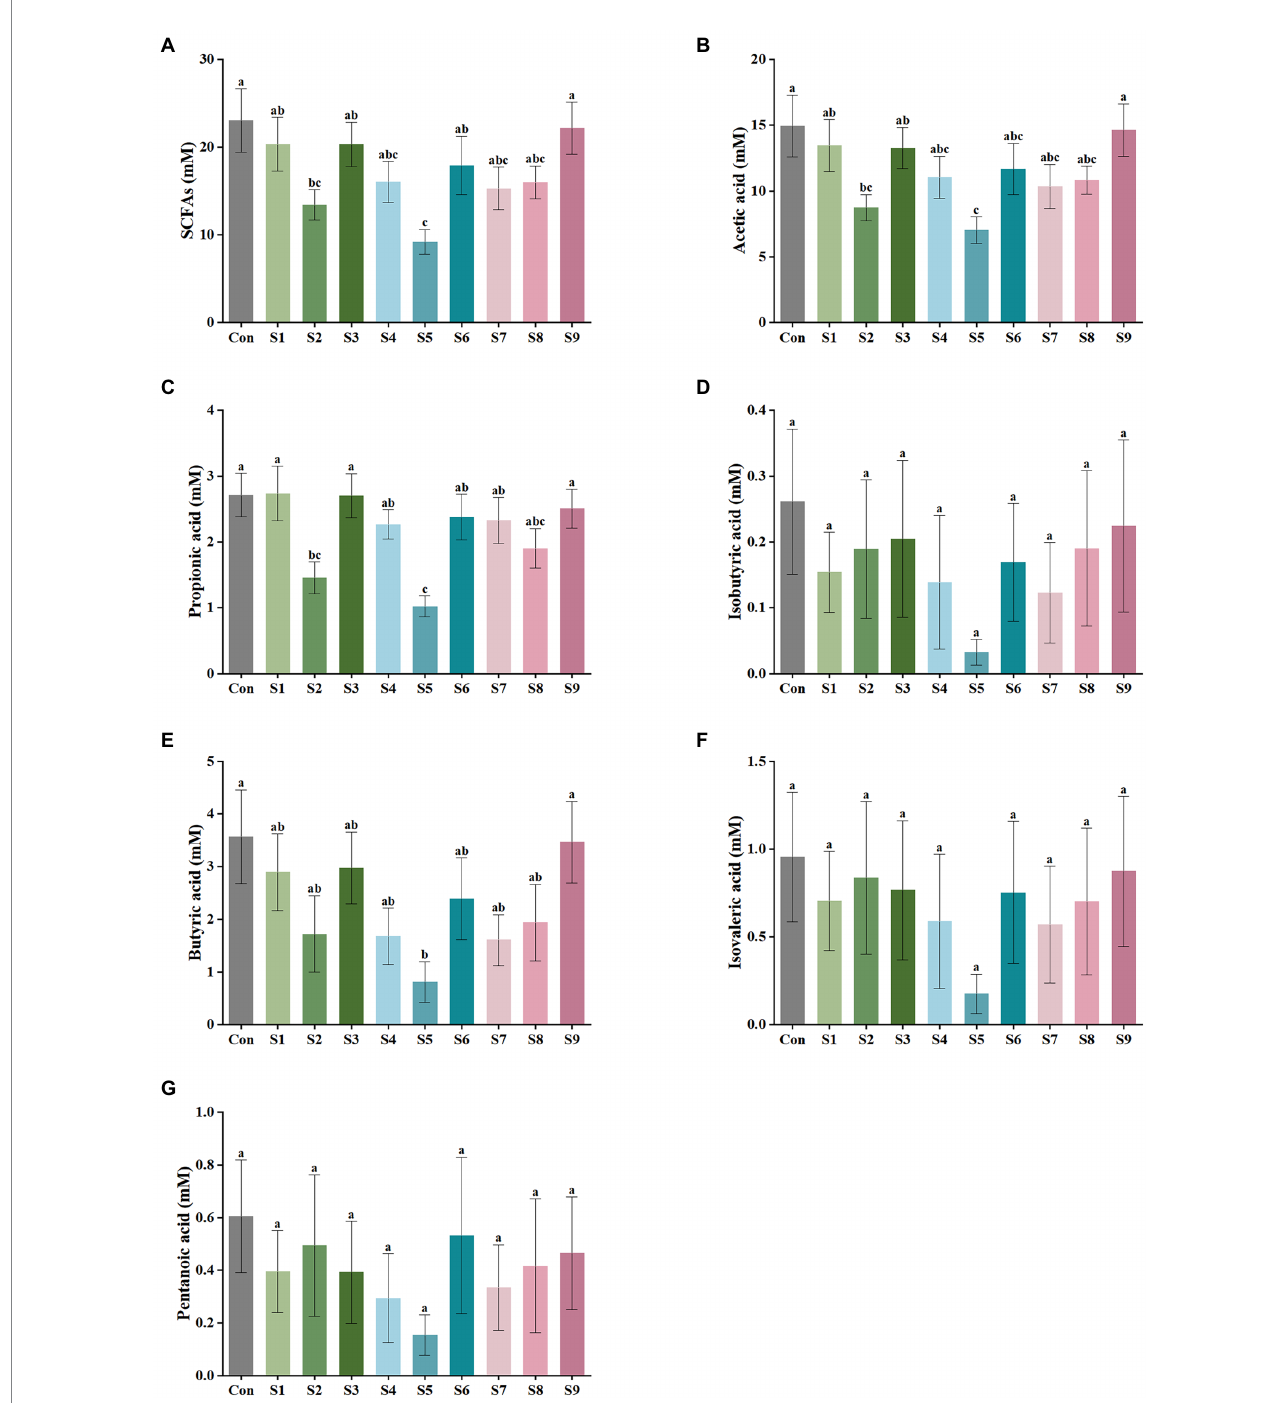
FIGURE 2 SCFA output of external fermentation of fecal microbiota under different substrate conditions. (A) Total SCFA yield, (B) Acetic acid, (C) Propionic acid, (D) Isobutyric acid, (E) Butyric acid, (F) Isovaleric acid, and (G) Pentanoic acid. Data are means ± SEM (10 independent experiments × 3 replication experiments). Different lowercase letters indicate significant differences ( p <